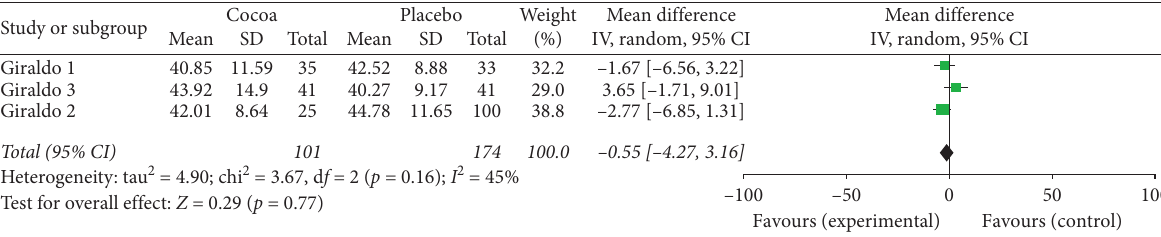
Figure 4: Meta-analysis of the effect of cocoa consumption on HDL cholesterol as compared with placebo. The sizes of the data markers indicate the weight of each study in the analysis. IV: inverse variance.